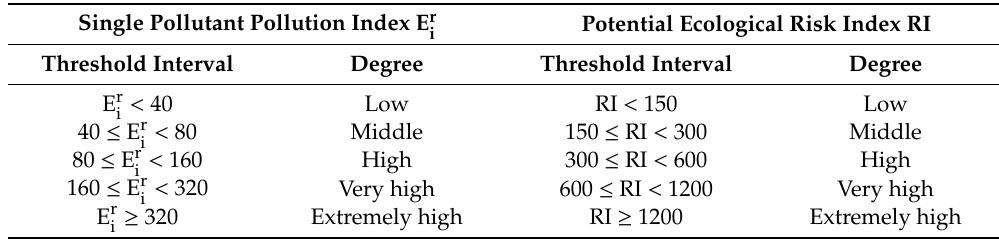
Table 2. Ecological risk index and grades of risk